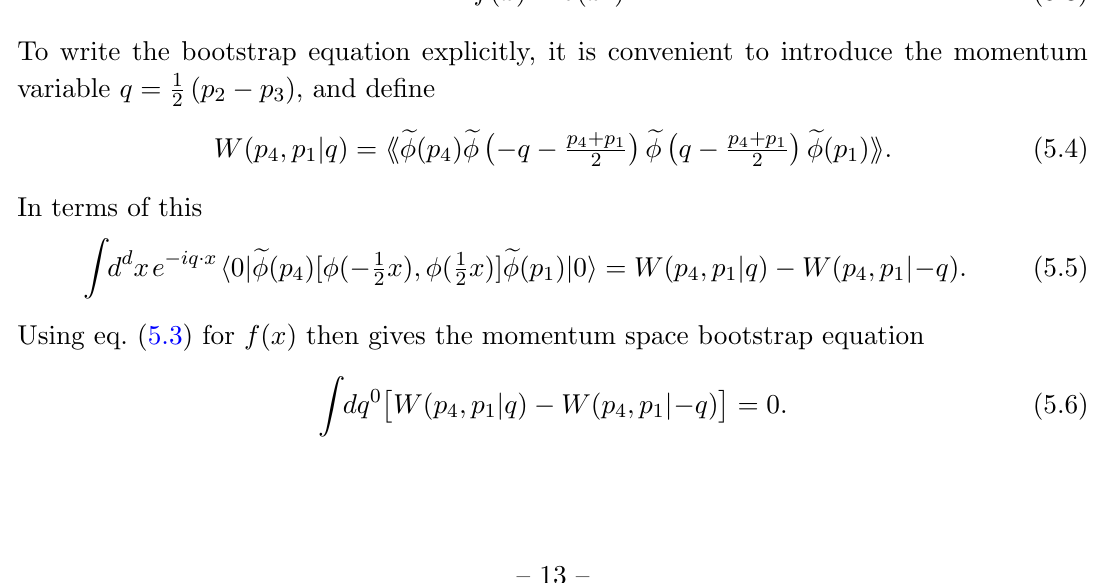
Figure 4 . The connected part of the 4-point correlation function function of the momentum k = k 1 + k 2 (red dashed line), compared with di(cid:11)erent truncations of the conformal block expansion (blue lines, with h max = 2 ; 4 ; 6 ; 8 ; 10 from lightest to darkest). Two di(cid:11)erent kinematic con(cid:12)gurations are shown, one in which k 1 k 4 (right which k 1 ’ (cid:0)